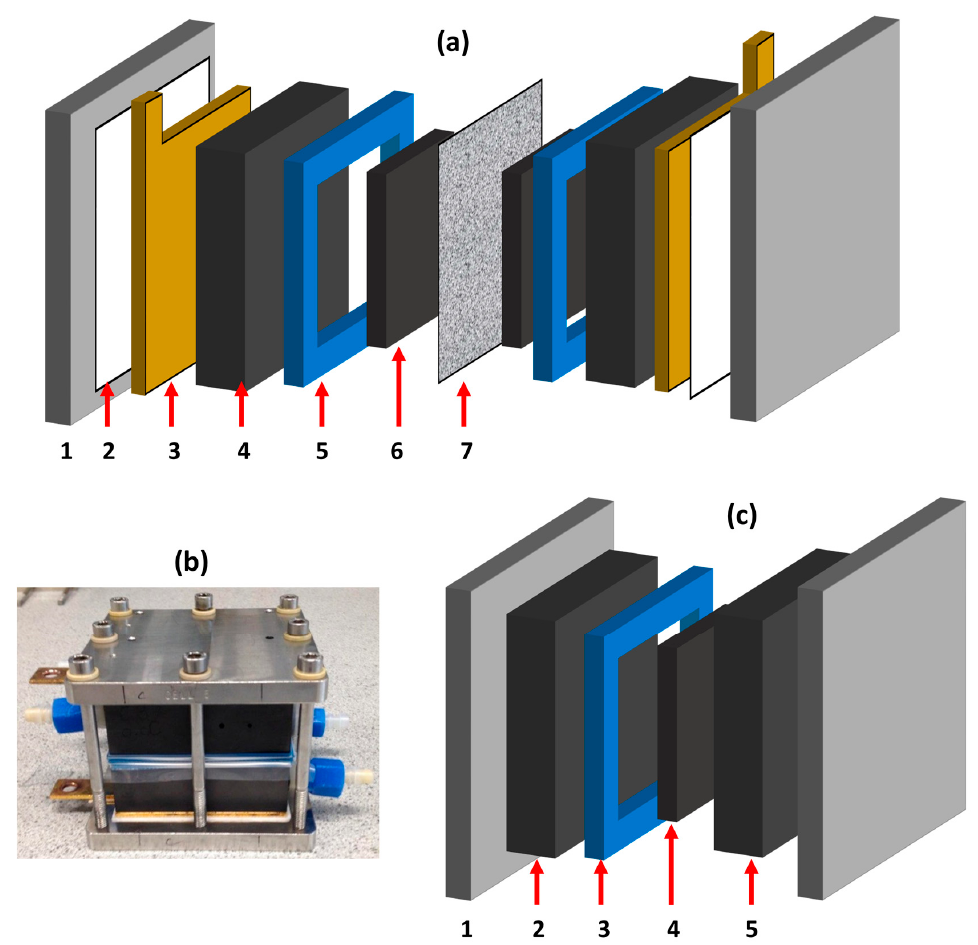
Figure 8. ( a ) Components in a single cell used for VRFB tests: 1 stainless steel endplate; 2 polytetrafluoroethylene sheet; 3 gold-plated copper current collector; 4 JP945 graphite block containing flow inlet and outlet (not shown); 5 polyolefin gaskets; 6 GFD 4.6EA felt electrode; 7 Nafion membrane. ( b ) Photograph of an assembled cell. ( c ) Components in a cell used for flow tests: 1 stainless steel endplate; 2 JP945 graphite block containing flow inlet and outlet (not shown); 3 polyolefin gaskets; 4 GFD 4.6EA felt electrode; 5 JP945 graphite block with no flow inlet or outlet.